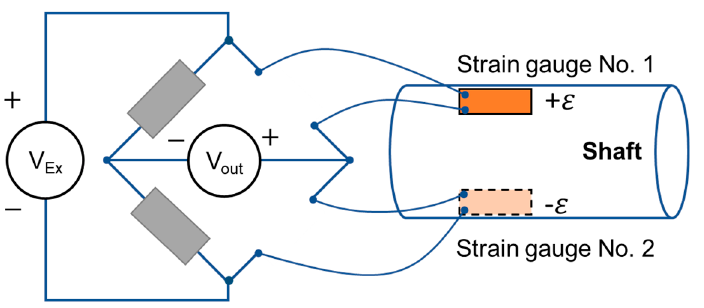
Figure 2. The Wheatstone half-bridge strain gauge configuration for bending moment measure- ment.